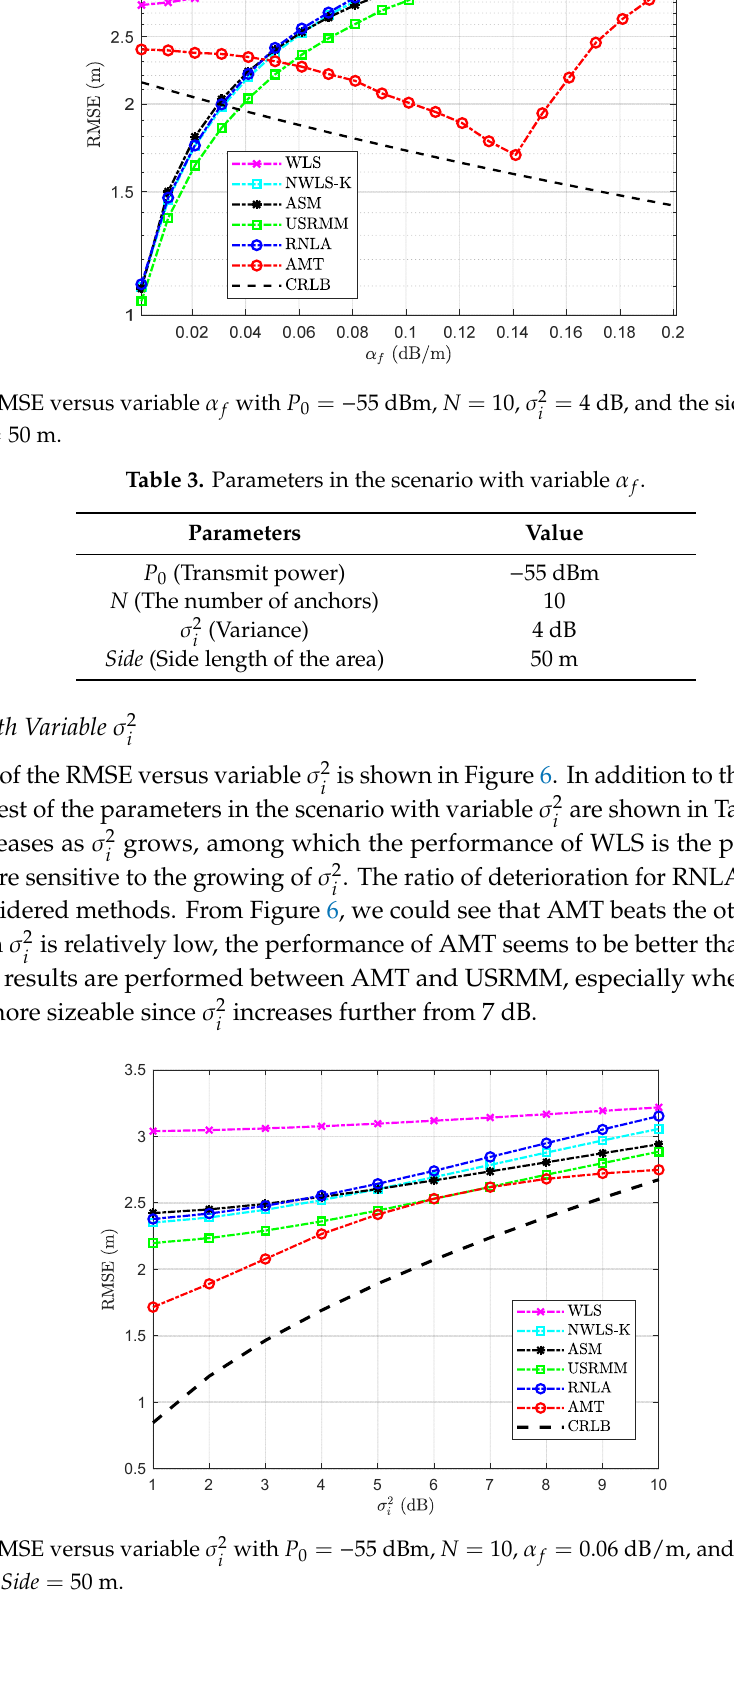
Figure 6. RMSE versus variable